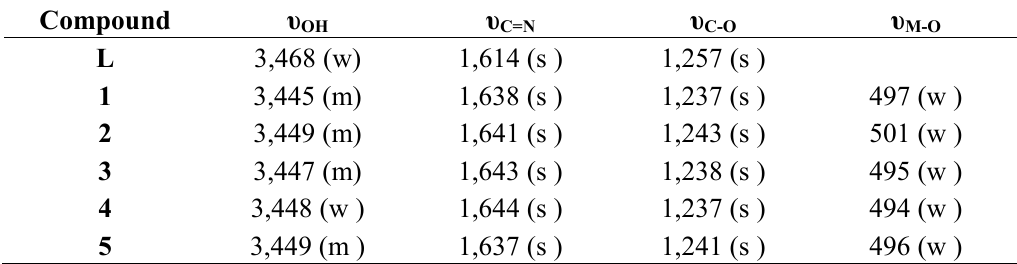
Table 2. Values of IR spectra for the ligand and complexes (cm -1 ).